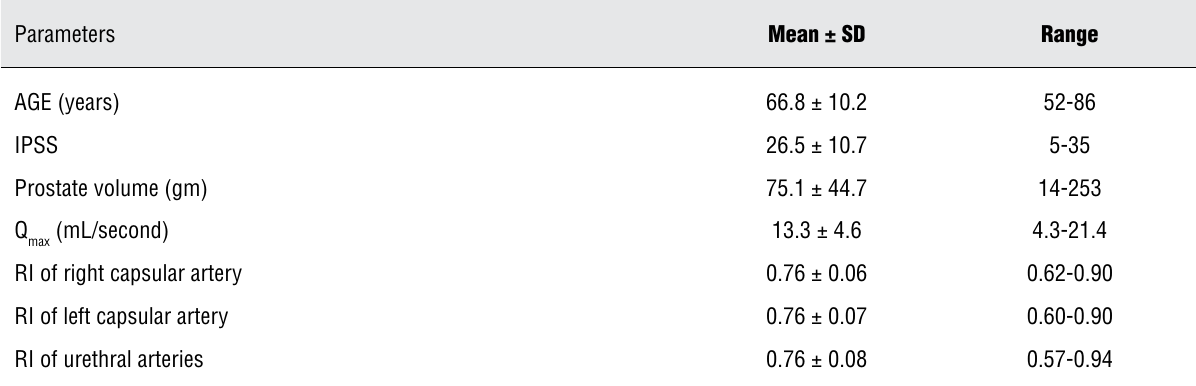
Table 1 - Summary of results.